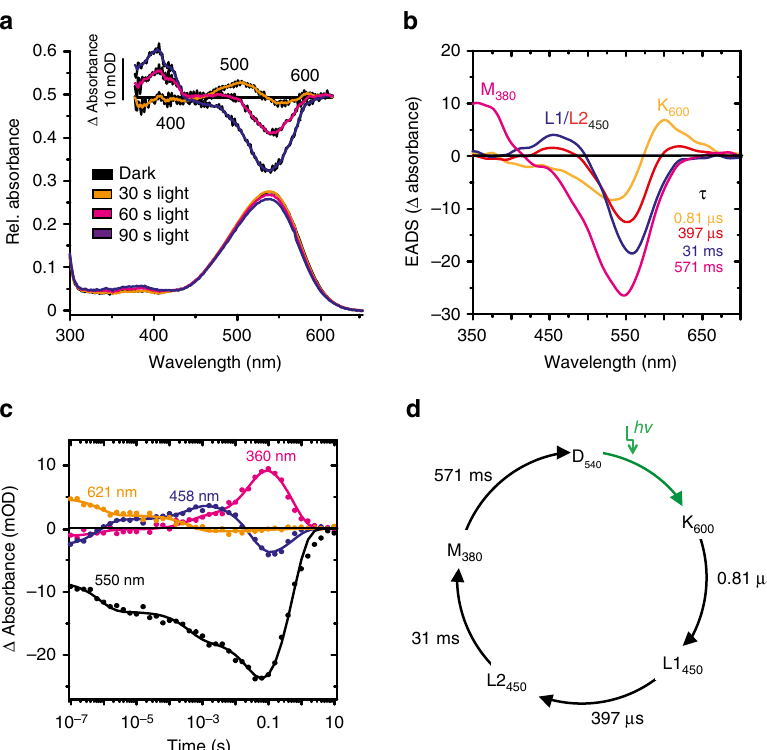
Fig. 3 Spectroscopic analysis of puri fi ed CaRh. a UV – Vis spectrum of CaRh (aa 1 – 396) in detergent at pH 7.5 before (black) and after illumination (30 – 90 s, 530 nm, 0.54mW mm − 2 ). Inset: light – dark difference spectra. b CaRh photocycle intermediates, depicted by capitals and absorption maxima, were identi fi ed by absorption changes (evolutionary-associated difference spectra (EADS)) after a short laser fl ash (10 ns, 532 nm, 15 mW). EADS and their life times (tau) are derived from a global fi t routine. c Temporal dependence of photo-intermediates determined from absorbance changes at the depicted wavelengths, which were identi fi ed in b , plotted against time. d Proposed photocycle model of CaRh, details are described in the text. (Black arrows indicate thermal (Table 1, Supplementary Fig. 4). In contrast to membrane embedded protein (Fig. 1e, Table 2), for both puri fi ed RhGCs a signi fi cant dark activity was detected and the cGMP production increased linearly with substrate concentration (Fig. 4a, Supple- mentary Fig. 4), suggesting a destabilizing effect of the detergent.